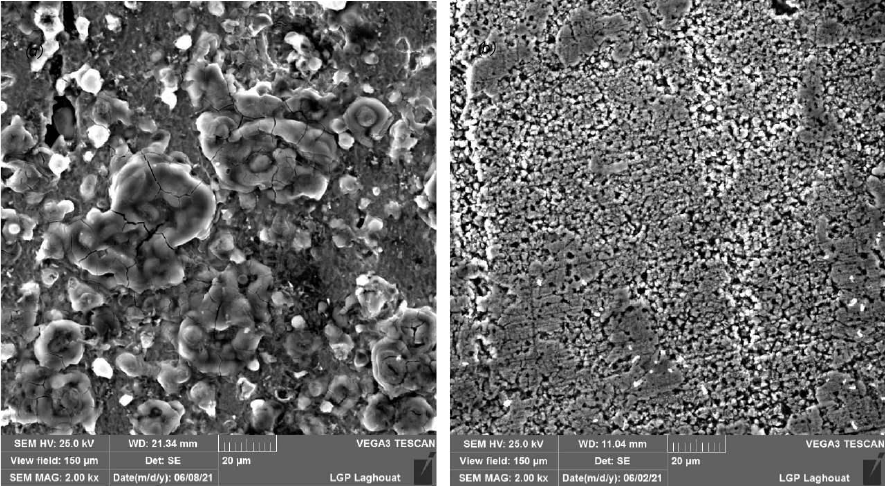
Fig. 5. SEM micrograph of corroded X52 steel after potentiodynamic polarization in 1M HCl solution a) Without boronizing b) With